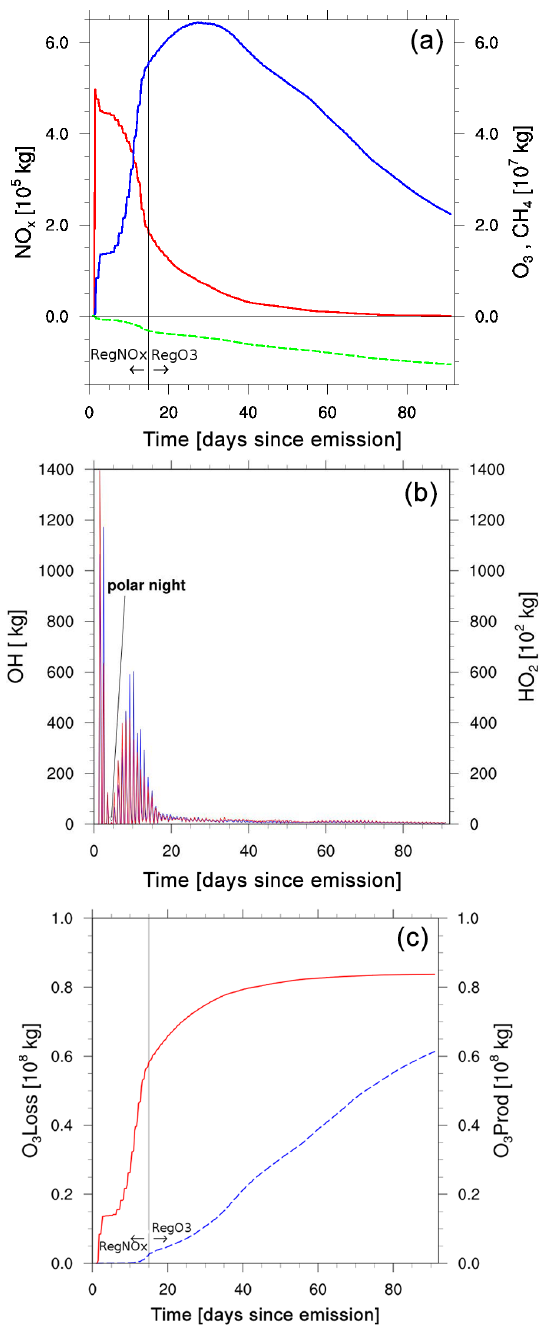
Figure 8. Temporal development of NO x -related species ( a : NO x (red), O 3 (blue), CH 4 (green), b : OH (blue), HO 2 (red)) and pro- duction or loss terms ( c : cumulative O 3 loss (blue) and cumulative O 3 production (red)) induced by a pulse emission at 45 ◦ W, 50 ◦ N and 300hPa on 23 December 2000. The discrimination between the regimes RegNO x and RegO 3 refers to the NO x dominated (days 1– 15 after emission) and the O 3 -dominated regime (days 16–90 after emission),